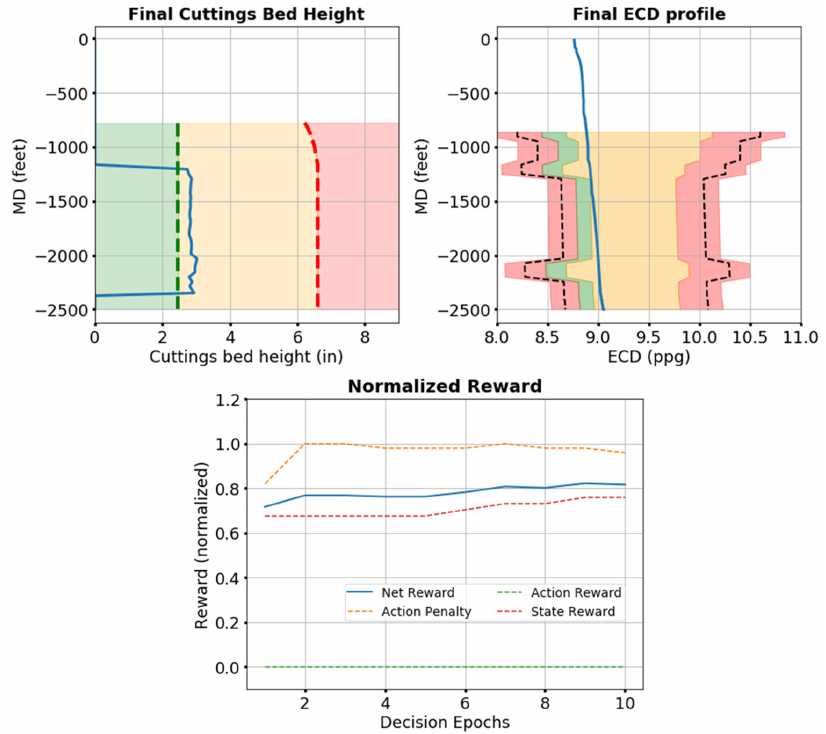
Figure 22. Predicted final system state and rewards after implementing action sequence five. Figure 23 shows the expected output of implementing action sequence six. This sequence would also result in a substantially reduced bed height (under 2.5 inches) and an ECD value very close to the desired region. The expected net and state rewards would be 0.86 and 0.81, respectively, the highest among all previous simulated trajectories. In this case, both the flow rate and the RPM are increased, from 833 to 1500 GPM and 83 to 150 RPM, respectively.